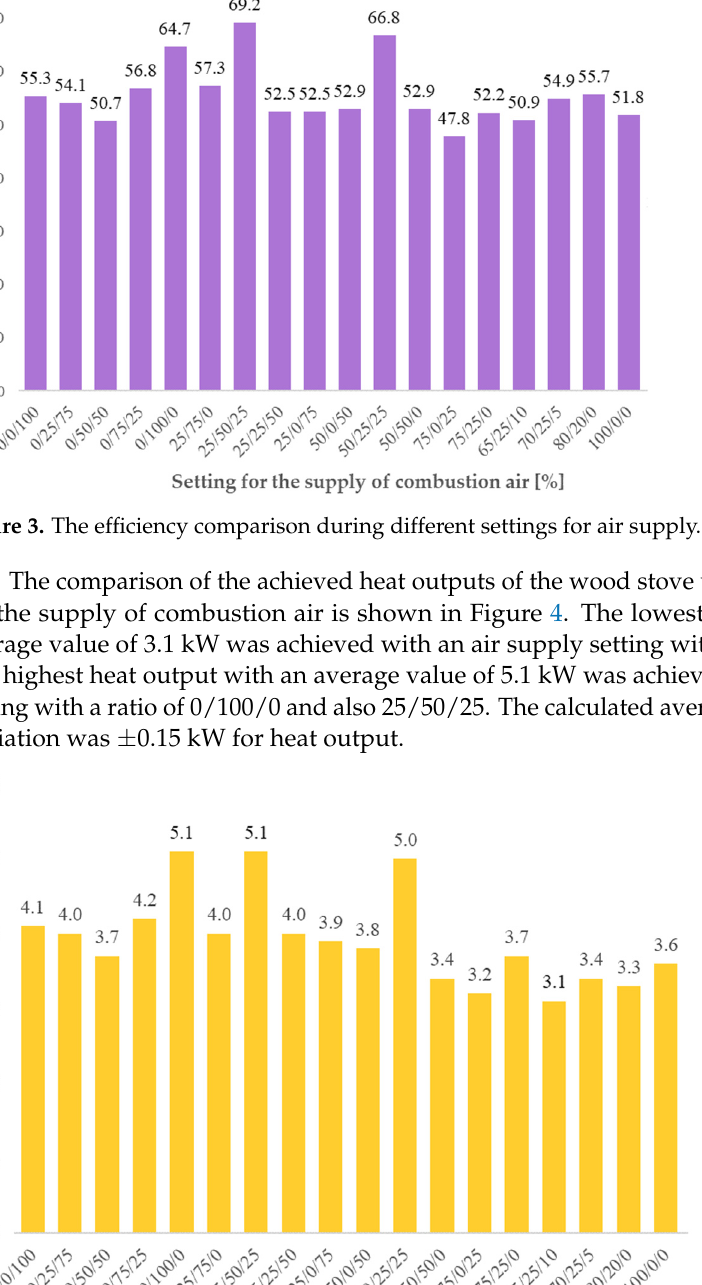
Figure 5. The carbon monoxide formation during different settings for air supply. The comparison of the detected nitrogen oxides during combustion in the wood stove with different settings for the supply of combustion air is shown in Figure 6. The lowest NO X13% with an average value of 88.7 mg ∙ m − 3 was achieved with an air supply setting with a ratio of 25/50/25. The highest NO X13% with an average value of 145.3 mg ∙ m − 3 was achieved with an air supply setting with a ratio of 80/20/0. The calculated average value of standard deviation was ±15 mg ∙ m − 3 for nitrogen oxides.